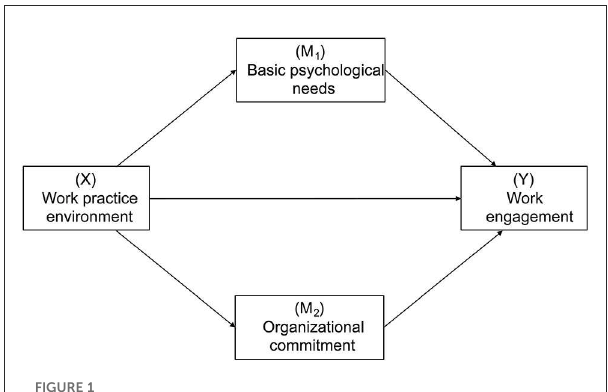
FIGURE1 The hypothesized